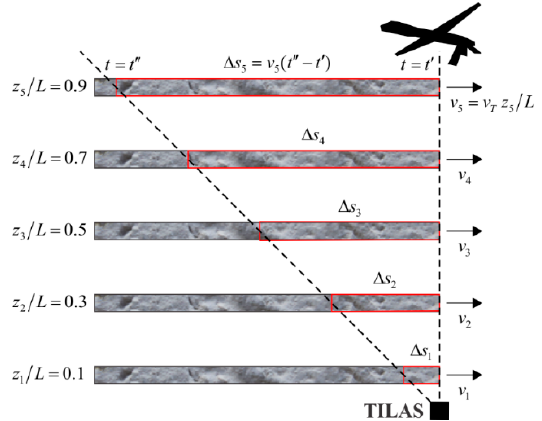
Figure 2. Schematic illustration of modeling the TILAS system operating with a target moving with speed v T in presence of distributed turbulence represented by five phase screens positioned at relative distances { z j / L }, j = 1, …, 5. Here, the target’s position is fixed, while the phase screens are shifted with the speeds { v j } in the direction opposite to the target velocity. The phase screen shift distances { ∆ s j } acquired during the time interval ∆ t = t (cid:48)(cid:48) − t (cid:48) are indicated by red bars.